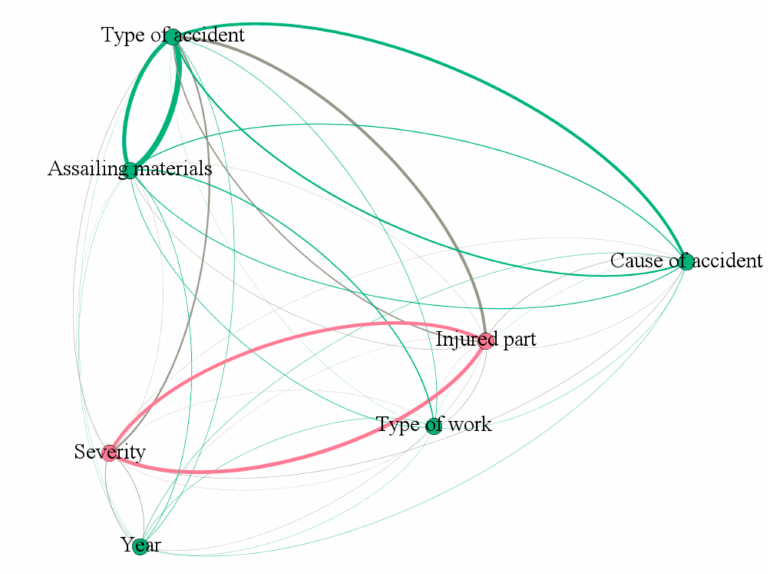
Figure 4. Visualization of contribution network between occupational accident